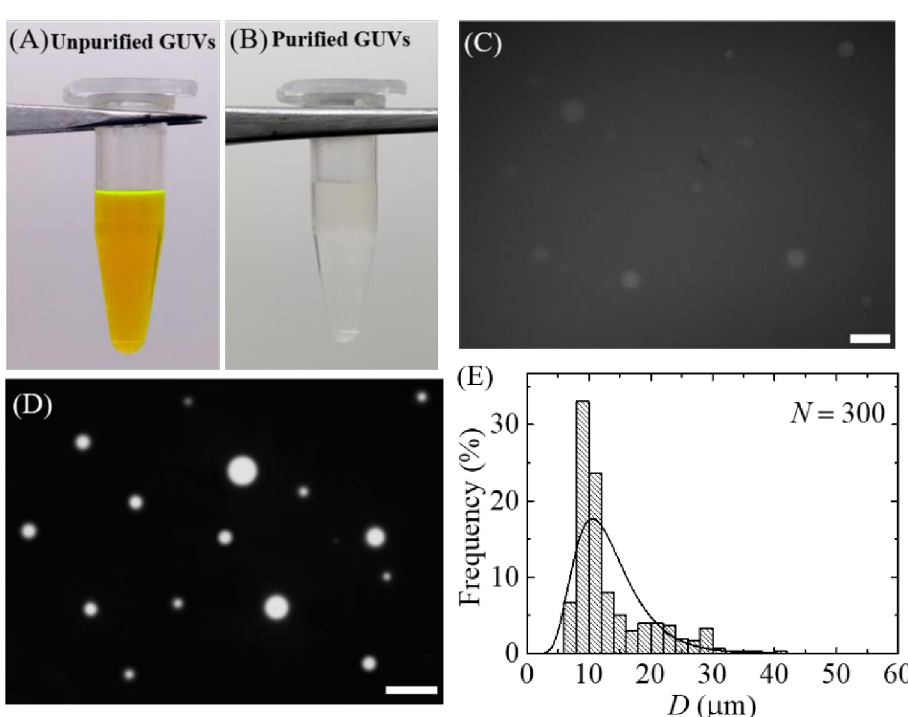
Fig 9. Purification of 40%DOPG/60%DOPC-GUVs containing calcein using the dual filtration technique. (A) GUV suspension before purification (B) GUV suspension after purification. (C) A fluorescence image of unpurified GUV suspension. (D) and (E) show the fluorescence image and the corresponding size distribution histogram GUVs in filter holder 2. The purification was performed at flow rate 1 mL/min for 1 h. The bar in the images (C, D) corresponds to a length of 50 μ m. The solid line of E corresponds to fitting with Eq 1.